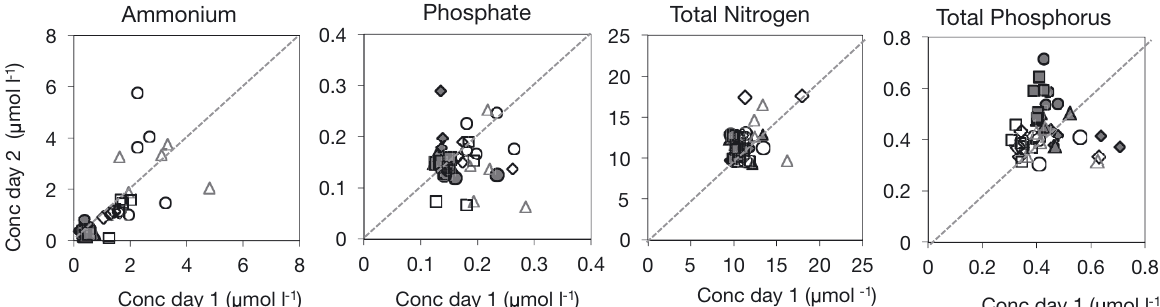
Fig. 8. Between-day variability. Similarity in nutrient concentrations taken on 2 consecutive days at 4 sampling stations ( s = Stn 3-farm, e = Stn 1–100 m west, n = Stn 4–100 m east, h = Stn 16–ref). Each symbol presents the average for 1 depth interval based on triplicate measurements. Solid ( d ) and open ( s ) symbols represent the sampling campaigns in April and September 2013, respectively. The diagonal line indicates a similarity index of